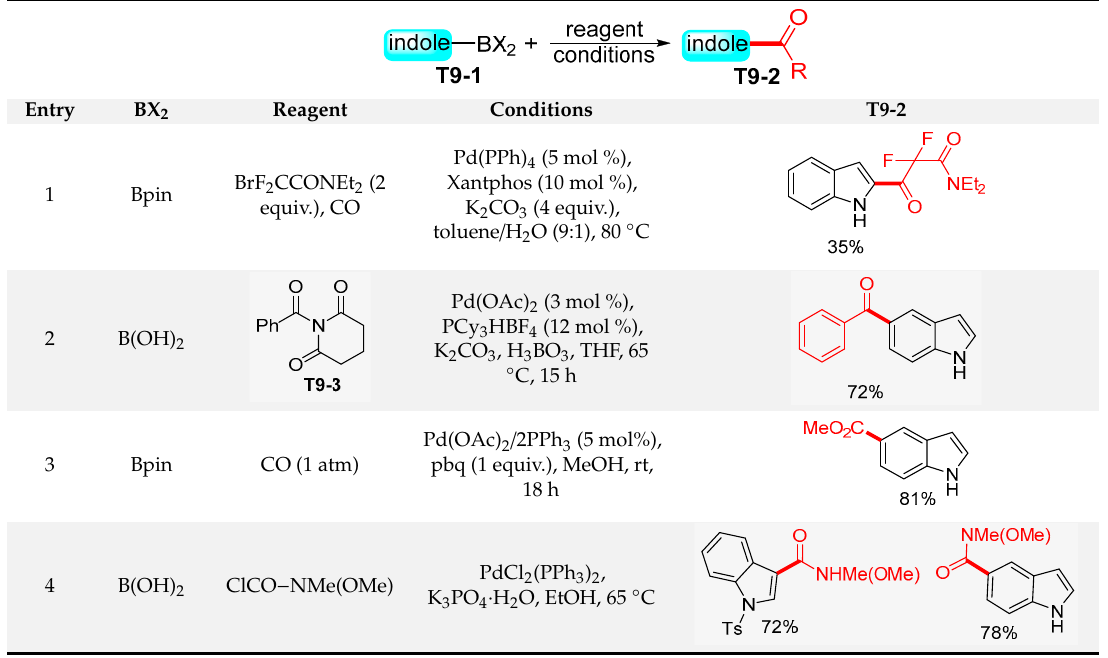
Table 9. Carbonylation of indolylboronic acids.